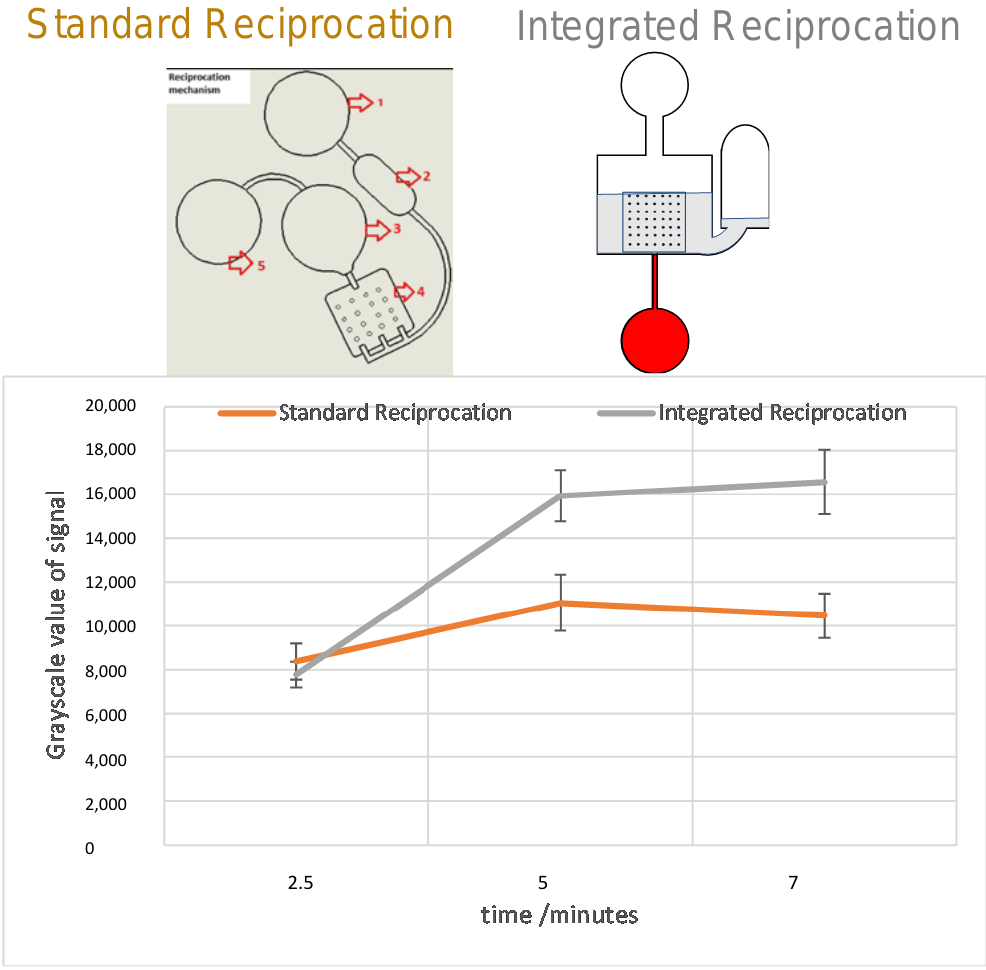
Figure 9. Comparison of the integrated reciprocation versus standard reciprocation with process times. We used Europium-coated streptavidin particles as the analyte to provide a signal when reacting with NC membrane-coated biotinylated BSA.